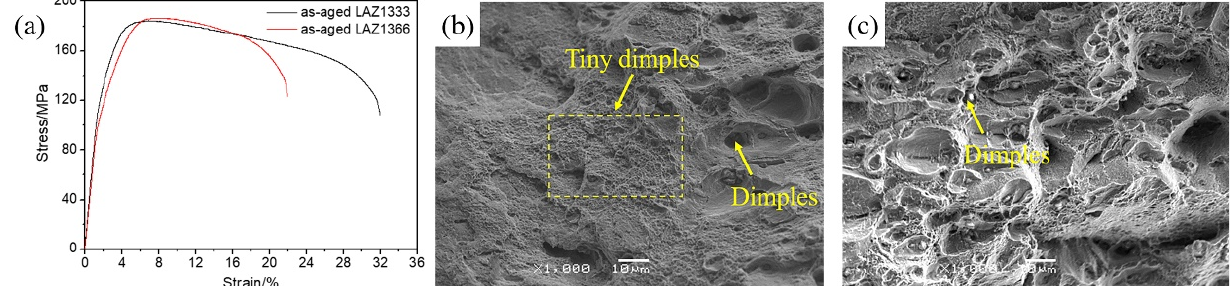
Figure 13. Room temperature tensile stress–strain curves and fracture morphology of the as-aged LAZ13 xy ( x = 3, 6 wt%, y = 3, 6 wt%) alloys: ( a ) tensile stress–strain curves, fracture morphology of as-aged ( b ) LAZ1333 and ( c ) LAZ1366.